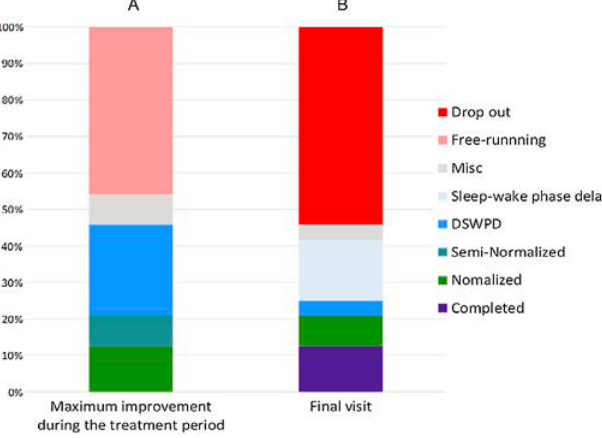
Figure 2 Treatment outcomes. Vertical axis represents the cumulative proportion (%), where 100% is equal to the total number ( n =24) of included patients with N24SWD. A. Maximum improvement achieved at any time (excluding the period of hospitalization) during the entire treatment period for each patient. Two patients were classified as “Misc” because they left our clinic within 1 month after improvement by hospitalization. B. Clinical state of each patient at the final visit (i.e., last observation). Patients were not necessarily in their maximally